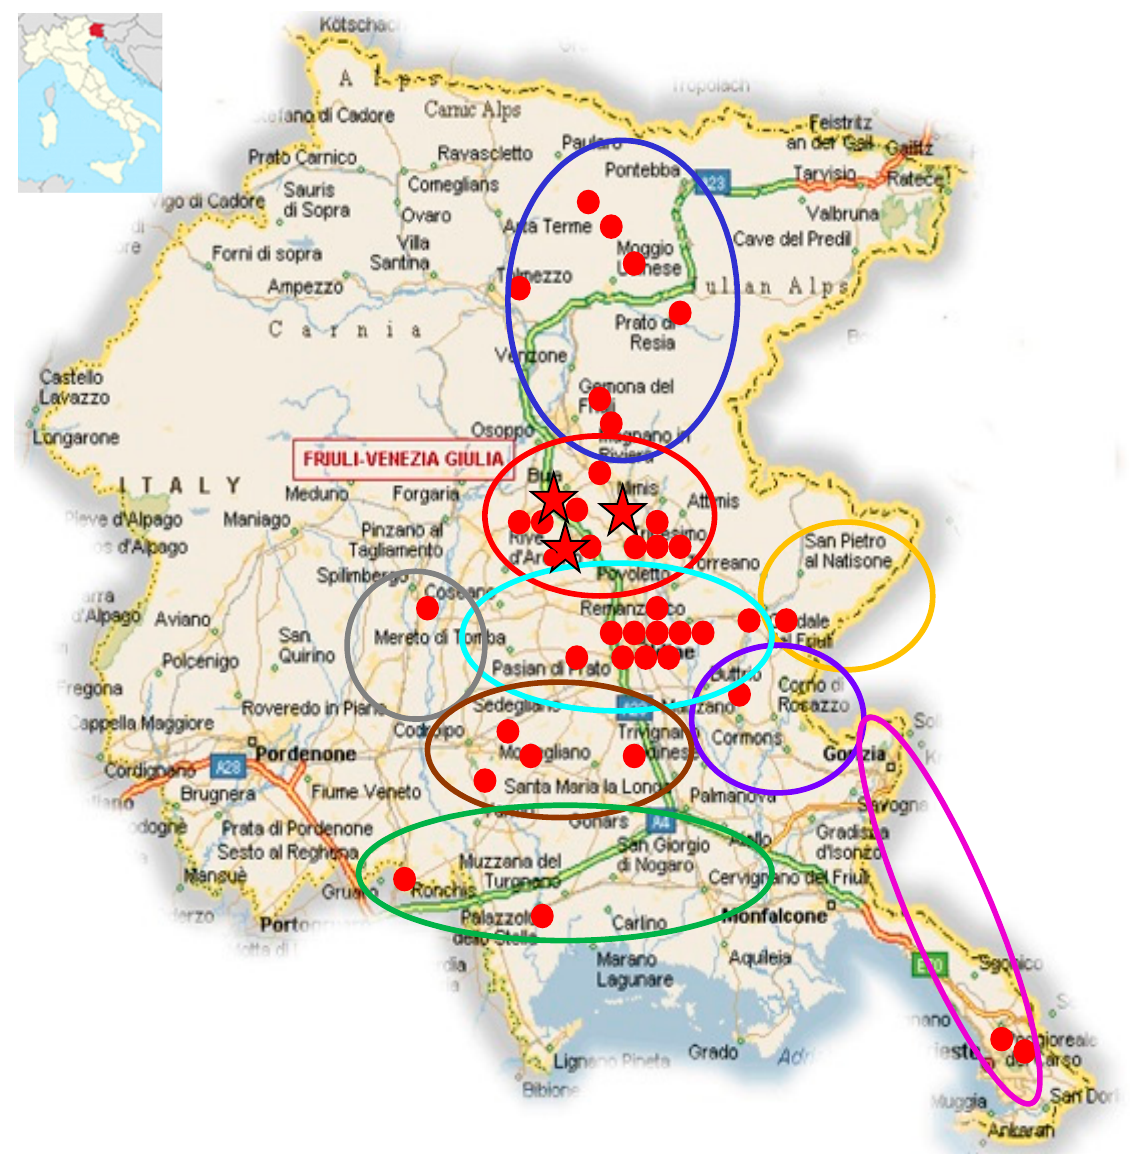
Figure 2. Geographic map of Friuli Venezia Giulia, Northeastern Italy, with the location of the nine areas of cat residence; red dots indicate seropositive cats, and red stars indicate the area in which sick cats were detected over 2005–2011. Municipalities included in the research areas were the following: